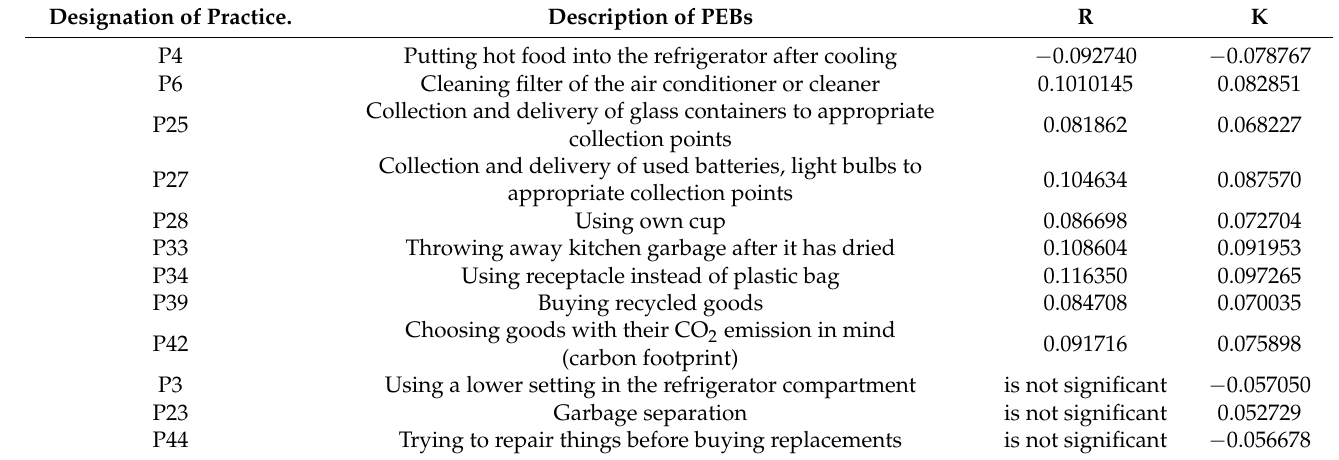
Table 7. Correlations (at the p = 0.05 level) between the respondent’s educational level and the frequency of using proenvironmental practices. Designation of